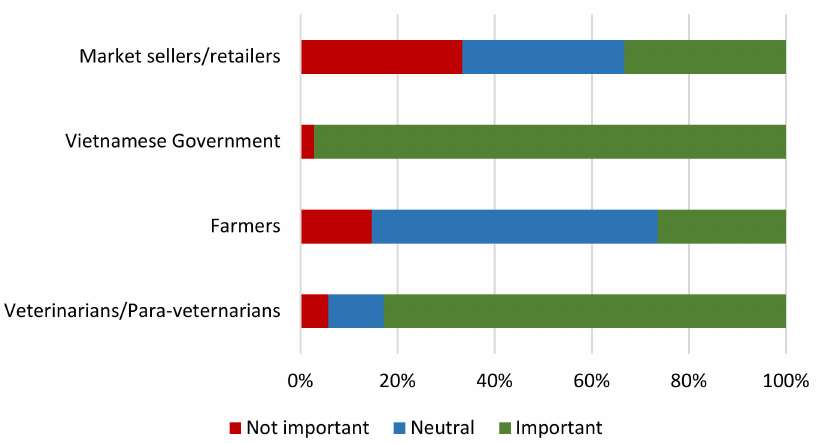
Figure 2. Farmer perceptions of the role of di ff erent actors in monitoring the use of antimicrobials in pigs.